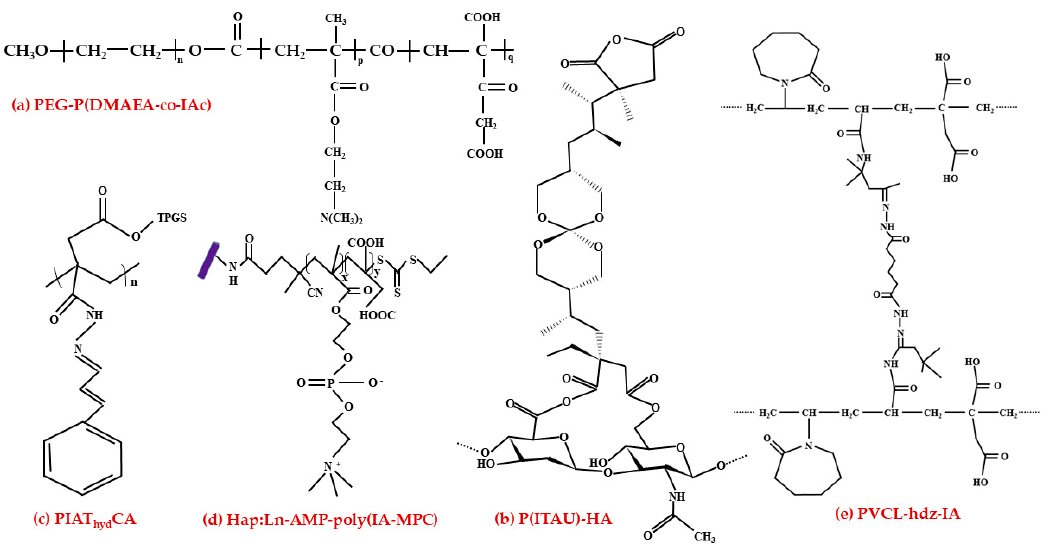
Figure 7. The chemical structure of IA synthesized nano-scale carriers ( a ) PEG-P(DMAEA- co -IAc), ( b ) P(ITAU)-HA, ( c ) PIAThydCA, ( d ) HAp:Ln-AMP-poly(IA-MPC), ( e ) PVCL-hdz-IA.